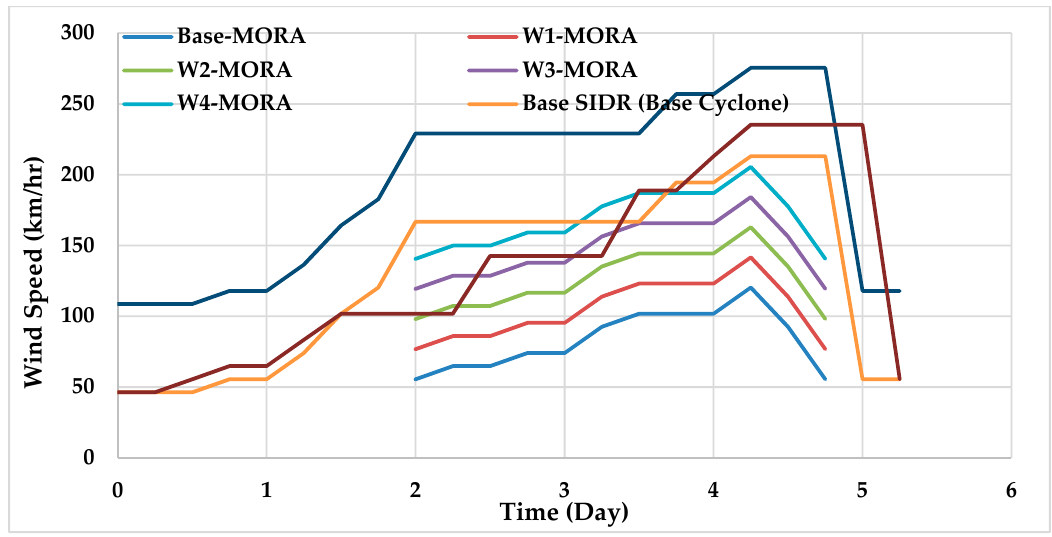
Figure 7. Wind increment from Base-MORA and Base SIDR.